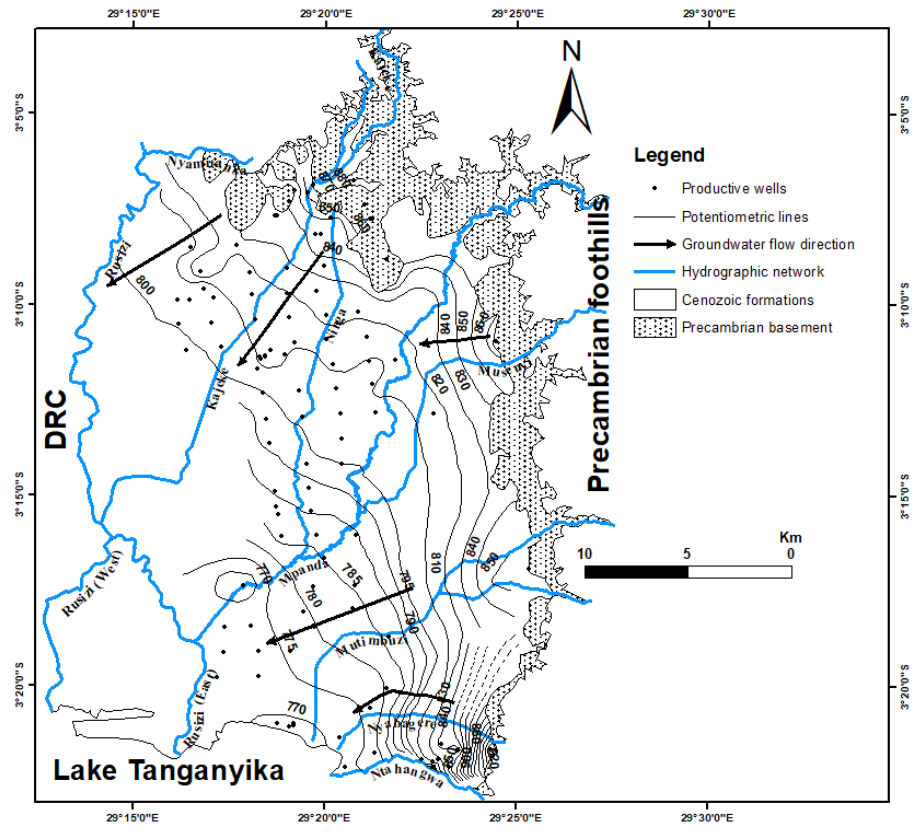
Figure 5. Reference piezometric map of the lower Rusizi plain.